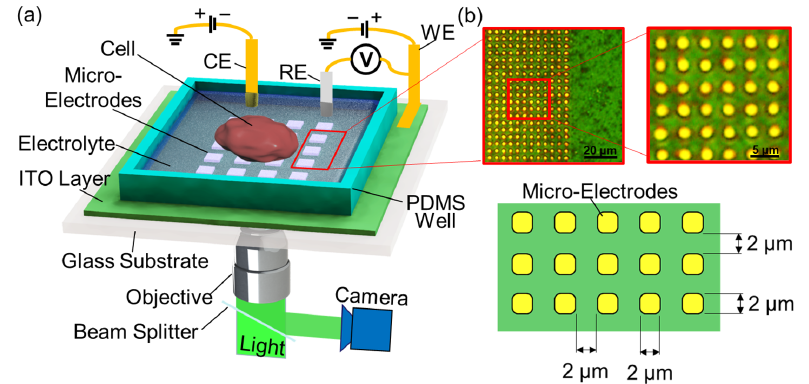
Figure 1. ( a ) Illustration of the method for rapid surface charge mapping. WE, RE, and CE are working, reference, and counter electrodes, respectively. The incident light illuminates the ITO layer from the backside. A cell sits on the surface of a microelectrode array. The local surface charge of the cell induces a change in the photoelectric effect. A CCD camera is used to capture the reflected light. ( b ) Microscopic images and scheme of the microelectrode array.